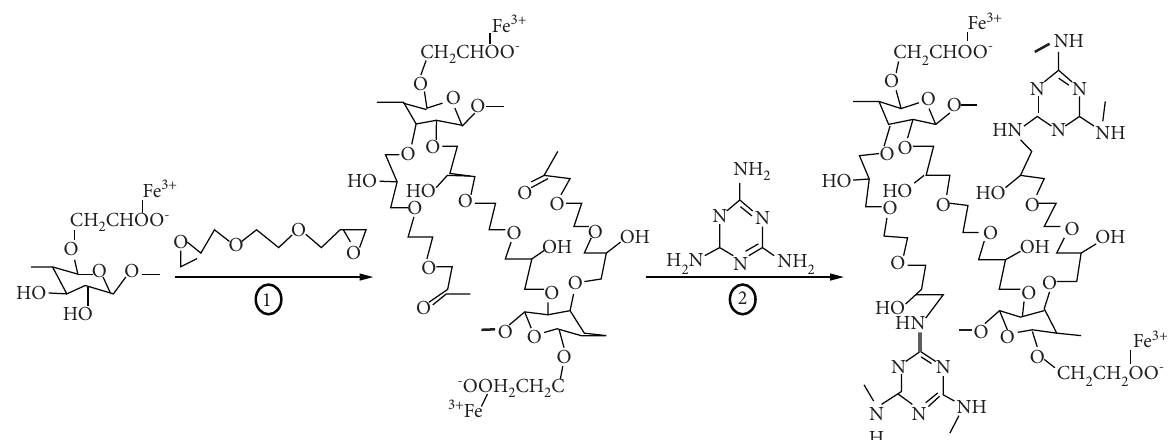
Figure 4: pH (a) and dosage of adsorbent (b) for Li + adsorption as well as temperature (c) and chloride acid concentration (d) for Li + desorption of